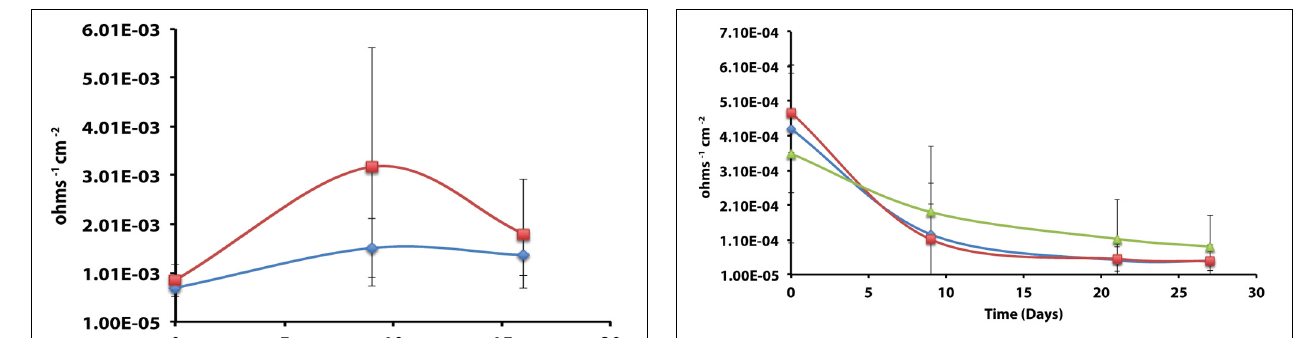
SO 4 • day − 1 (Figure S16). For comparison, Desulfovibrio sp. strain G11 cultured with lactate, H 2 /CO 2 overpressure, or hydrogen emanating from the coupon reduced sulfate at 1.08 ± 0.006,